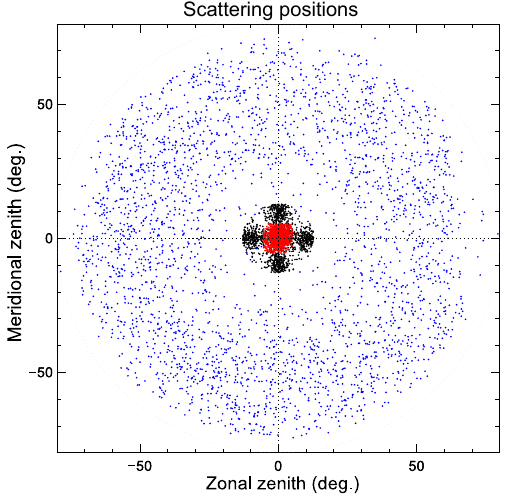
Figure 5. A 48h sample of scattering position data used in the model (black: 5BD; red: VBD; blue: meteor.) See text for